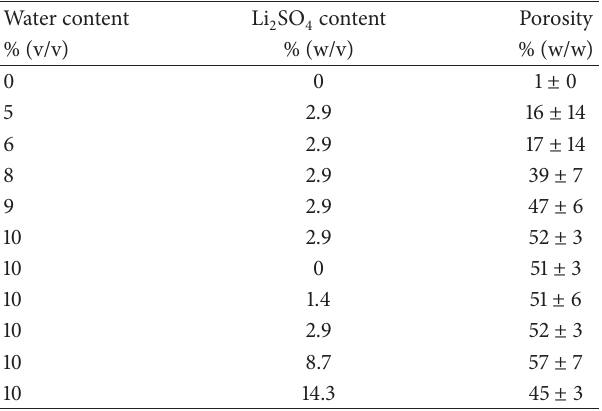
Table 1: The porosity of films casted from template emulsions with a variation in water volume and lithium salt content ( 𝑛 = 3